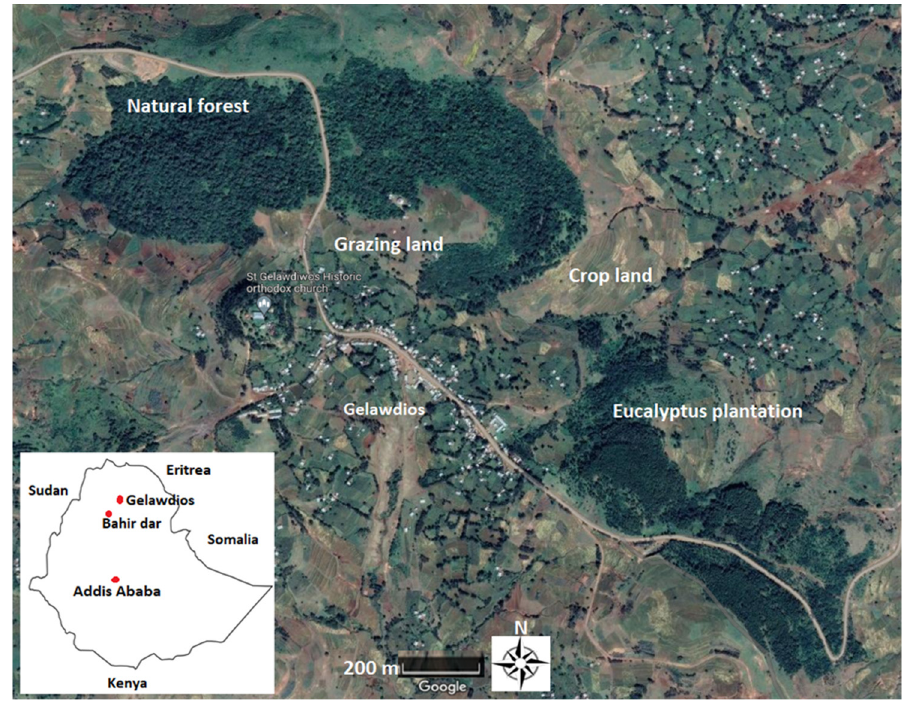
Figure 1. Location of study area: Gelawdios, Ethiopia. Four chrono-sequence land-use types in one landscape.